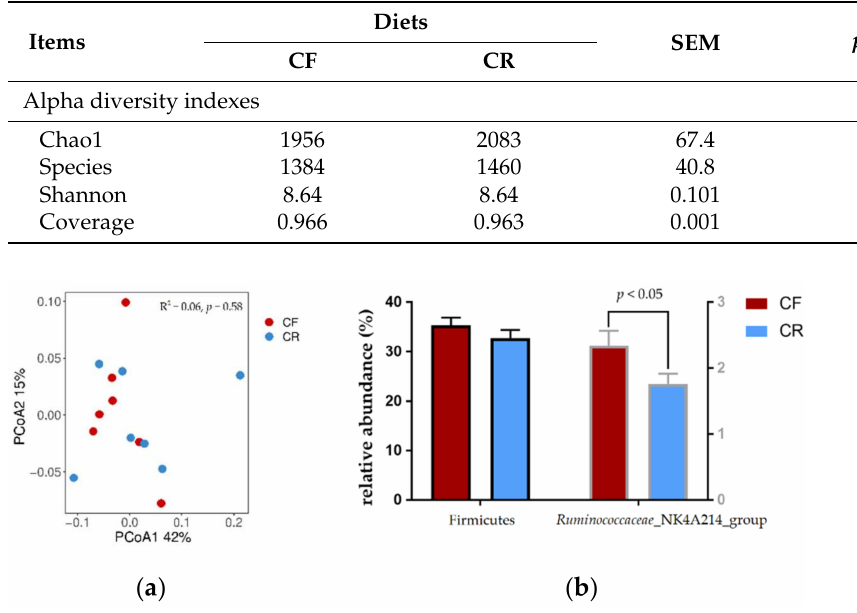
Figure 1. Bacterial community analysis based on the 16S rRNA gene sequencing. ( a ) The principal coordinate analysis (PCoA) of bacterial community based on Bray–Curtis dissimilarity matrix at the genus level. R 2 = 0.06, p = 0.58. ( b ) The selected bacterial phyla and genera with significant differed between treatments, while other were present in Table S1. CF, silage diet with corn stover after fresh-corn harvested; CR, silage diet with corn stover after ripe-corn